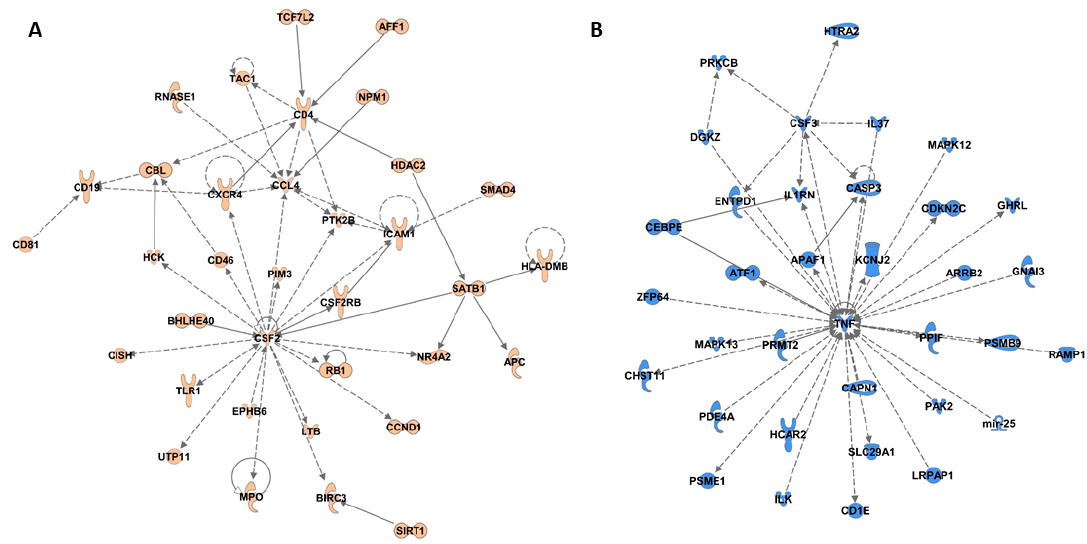
Figure 2. Ingenuity pathway analysis protein–protein interaction networks derived from genes within 5 kb of a low P-value CpG site ( P < 0.01). ( A ) Fruit associated network 1 is centered on colony stimulating factor (CSF)2, cluster of differentiation (CD)4, and C-C motif chemokine ligand (CCL)4 (network score 38); ( B ) Juice associated network 1 is centered on tumor necrosis factor (TNF) and colony stimulating factor (CSF)3 (network score 38). Genes that were associated with fruit or juice-specific epigenetic signatures are colored in orange or blue, respectively.